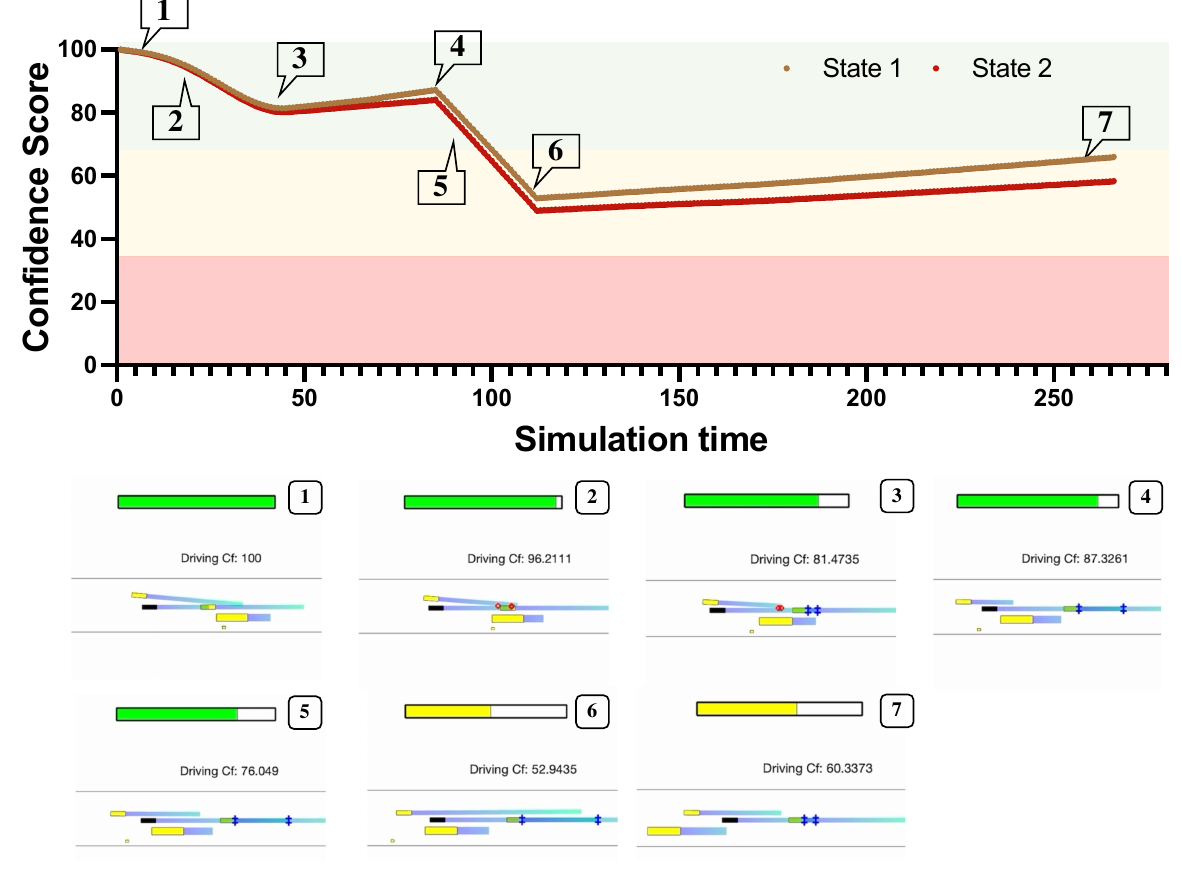
Figure 5. Real-time VC value in scenario one.